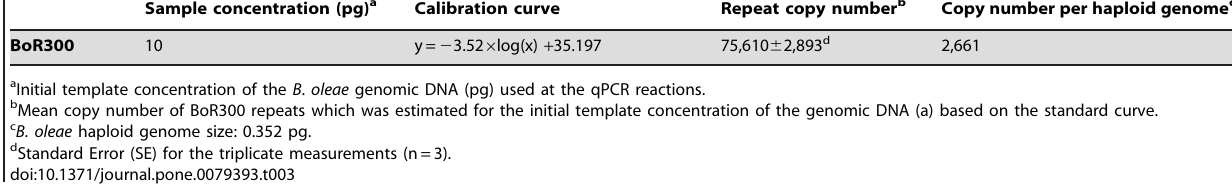
Sample concentration (pg)